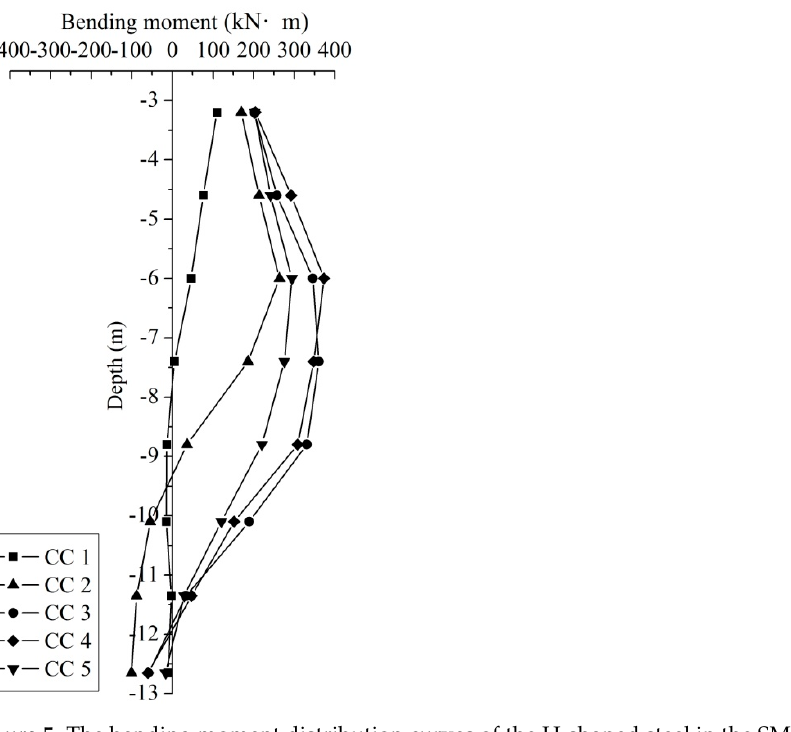
Figure 5. The bending moment distribution curves of the H-shaped steel in the SMW pile Z1 under five construction conditions (construction condition is abbreviated “CC”).